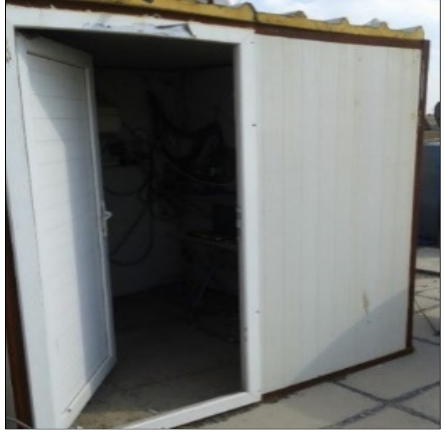
Fig. 6. Test room.